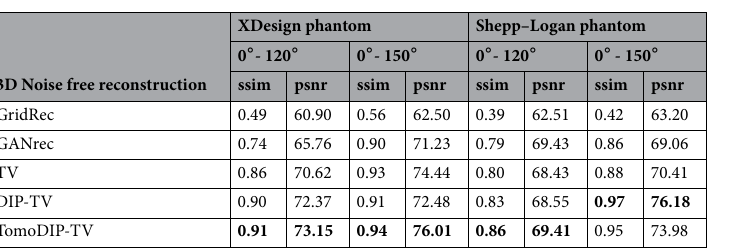
Table 1. Quantitative comparison of reconstruction qualities from noise-free projections (Best SSIM and PSNR results per number of projections are shown in bold).